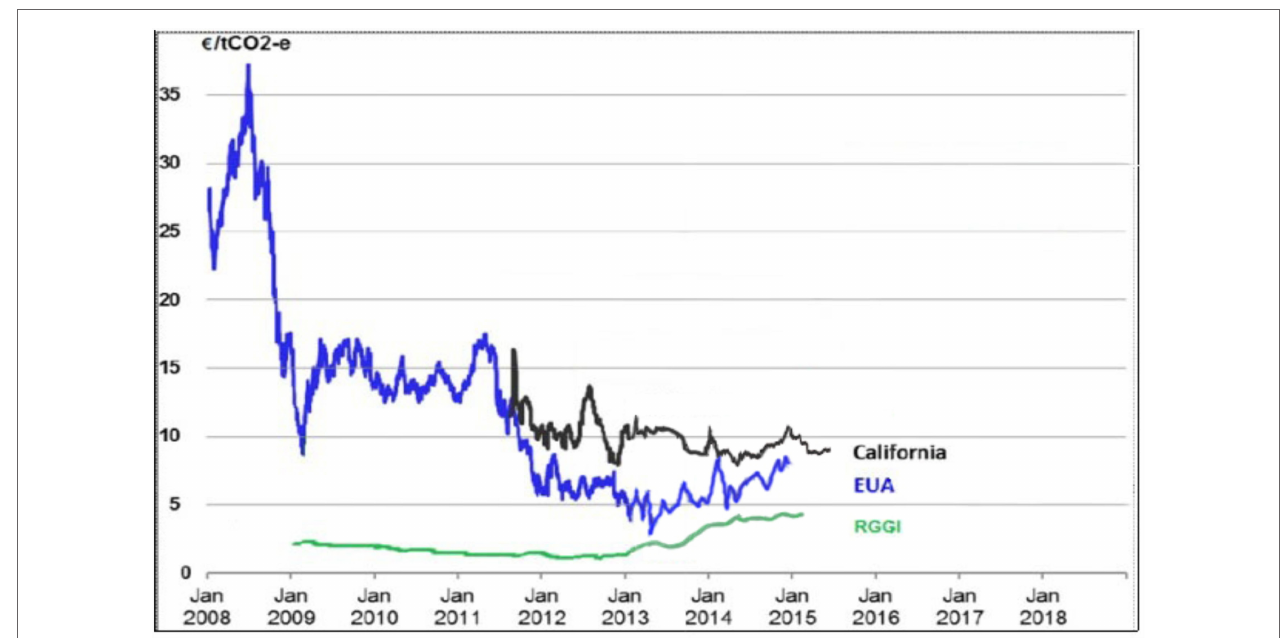
FiGURe 2 | intertemporal evolution of emission allowance prices on different eTS markets . Source: authors’ own elaboration based on EEX data (https:// www.eex.com/en#/en), CARB data (http://calcarbondash.org), and RGGI data (https://rggi-coats.org/eats/rggi/index.cfm?fuseaction=reportsv2.price_